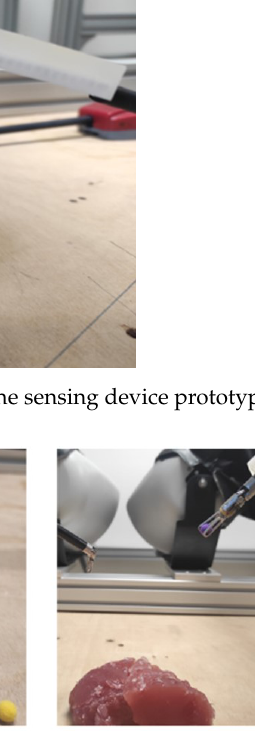
Figure 12. Three frames concerning the phases of the performed transfer task, taking the ball from the workspace and positioning it about 8 cm from the tissue.